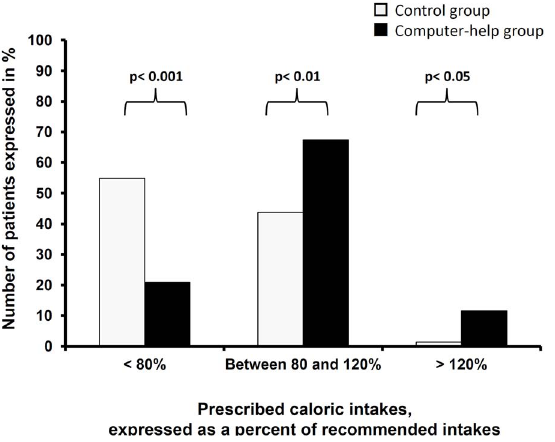
Figure 3. Calorie intake prescribed before and after imple- mentation of the computer help expressed in percent of recommended goals for artificial nutrition. Introducing the computer help was associated with a significant increase in the number of patients whose prescribed calorie intake was at least 80% of recommended goals.